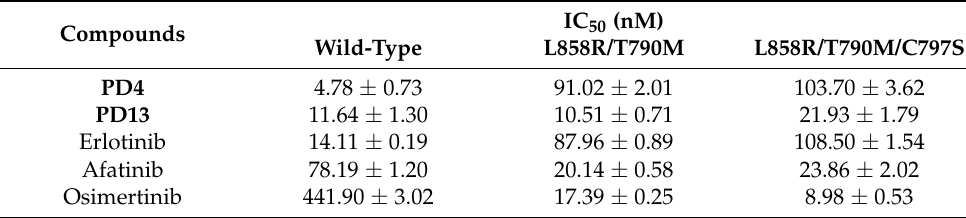
Table 2. EGFR inhibitory activities of focused PD and drugs in different forms of EGFR.